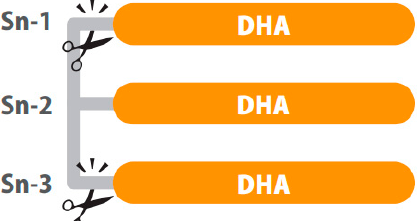
Figure 1. A triglyceride of DHA digested by lipases. The sn-1 and sn-3 positions of the glycerol backbone are cleaved while the fatty acids of the sn-2 position remains. Image courtesy of Brudylab ® .